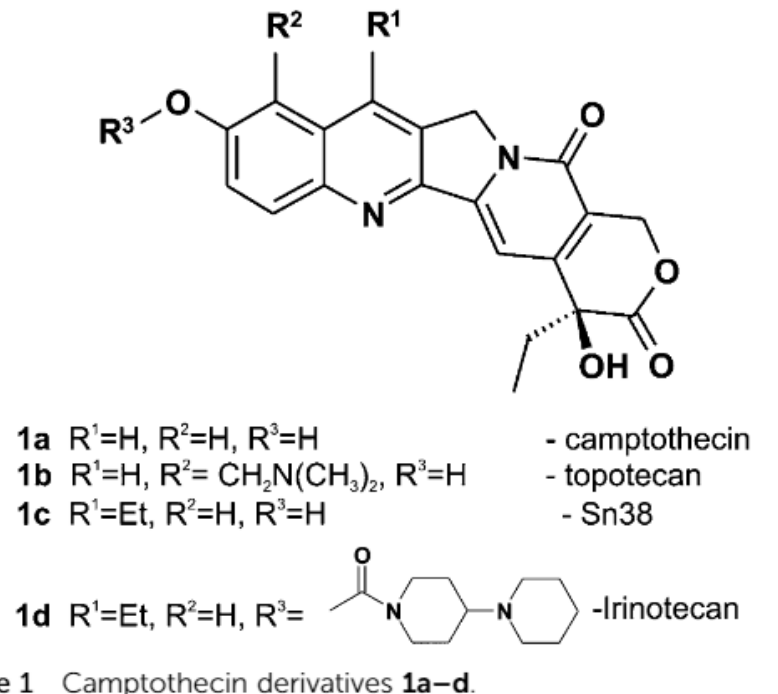
Figure 8. Camptothecin and derivatives. Taken from Ref. [32], with permission from WILEY-VCH Verlag .